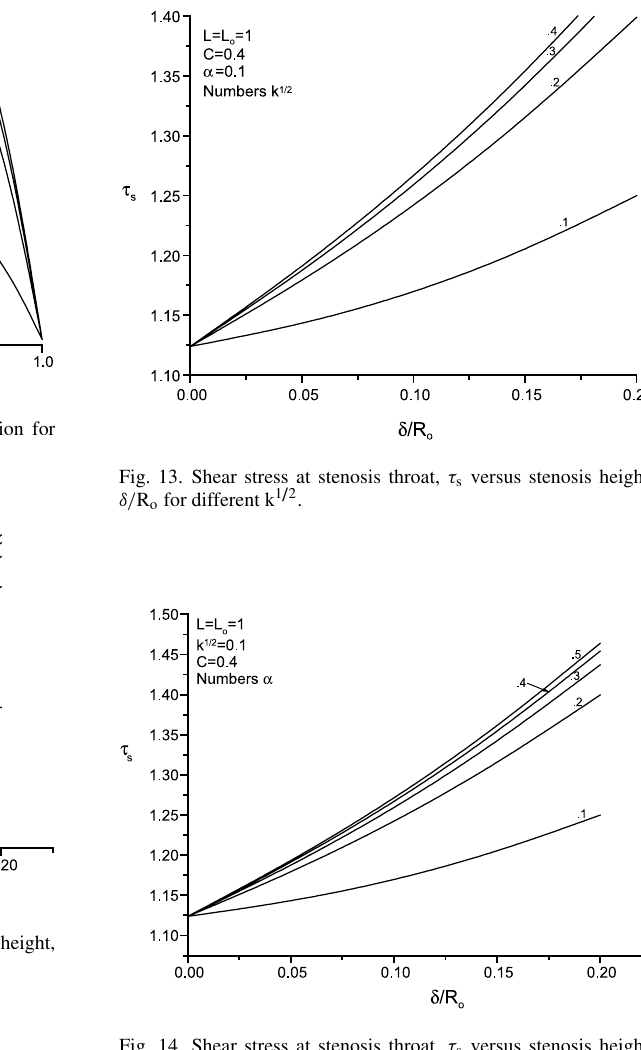
to that of the flow resistance, λ with respect to any parameter. The shear stress at stenosis critical height, τ c too increases with the hematocrit, C, Darcy number, √ k, slip parameter, (cid:3) and the stenosis height, δ/R (Fig. 15). The variations in τ c is similar to that of the shear stress at stenosis throats, τ s and the impedance, λ with respect to any given parameter. However, τ c assumes significantly smaller magnitude than the corresponding magnitude of the shear stress at stenosis throats, τ s (Figs.